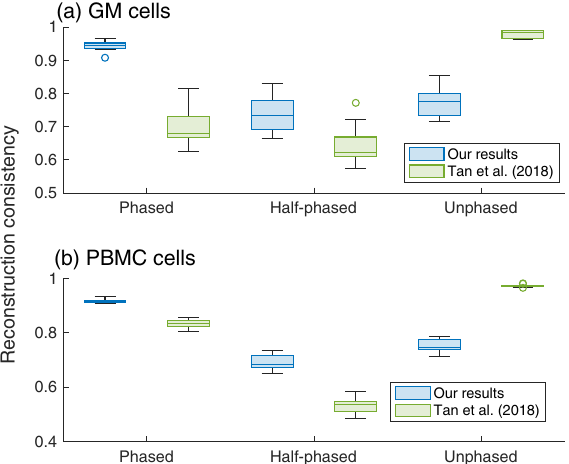
Figure 3. Self-checking results of the reconstructed 3D structure at a 40-kb resolution. Ratios where two close segments in a chromosomal contact for a single Hi-C are within the detection limit distance of 22/27 in the proposed method (see Supplementary Material for the derivation of the number “22/27”), depending on three conditions: both segments with SNVs (phased), only one of two segments with SNVs (half-phased), and both segments without SNVs (unphased). For obtaining the ratios, we used the number of all the corresponding contacts in each single diploid cell Hi-C data as the denominator for each cell. For the results of Ref. 13 , the detection limit distance is obtained by multiplying 22/27 and the ratio of the estimated mean distance for the reconstructions of Ref. 13 against that of our results. Panel ( a ) GM cells and ( b ) PBMC cells, where our results are on the left and those of Tan et al. 13 are on the